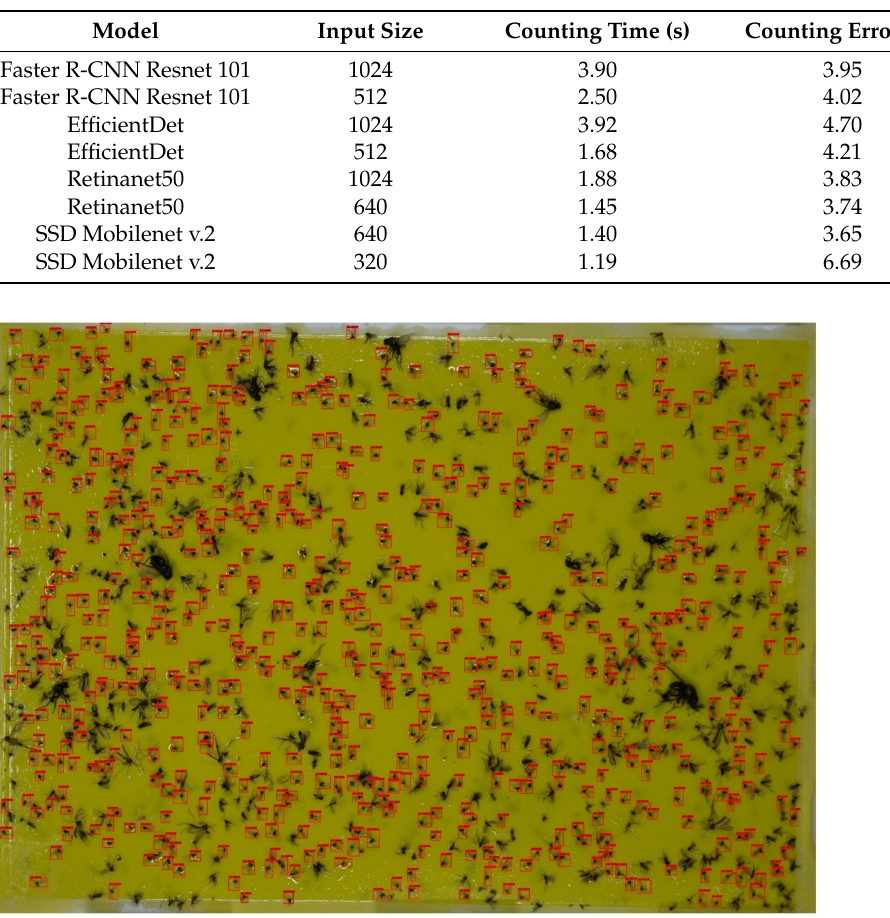
Figure 11. Detection results of the trap image (Faster R-CNN Resnet101 with a 1024 input size, a 12 × 8 cropping condition, and a 0.5 score